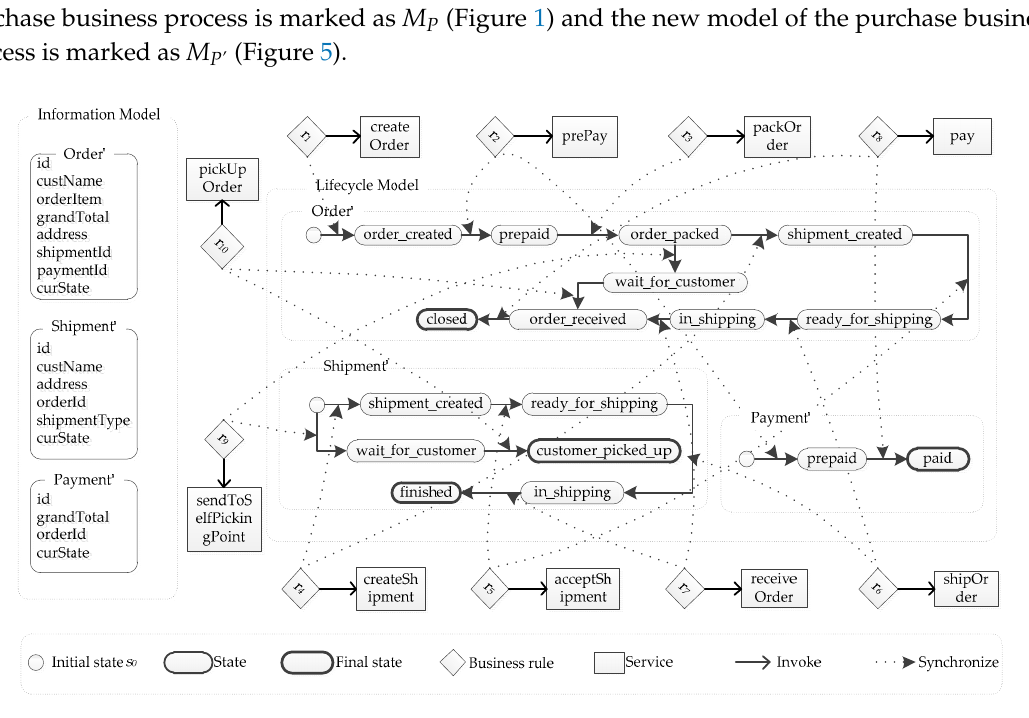
Table 3. The adaptation rule r a that is used for the adaptation.